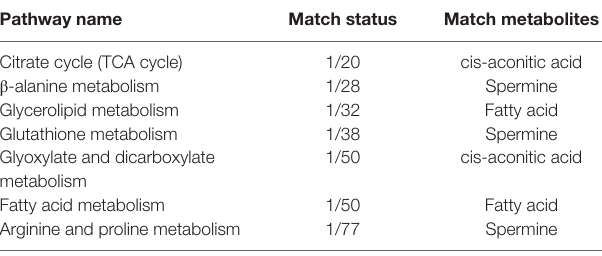
TABLE 4 | Differential metabolic pathway between the XFZY group and placebo